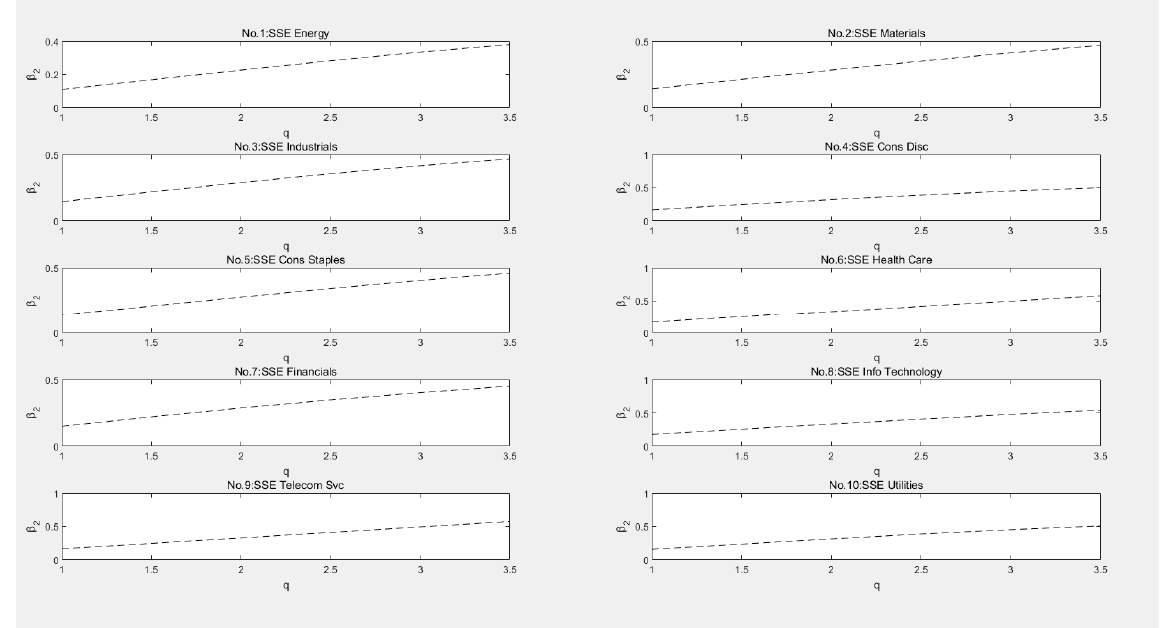
Figure 4. β 2 against q based on the logarithm of non-truncated spot volatility for the 10 industrial indices.